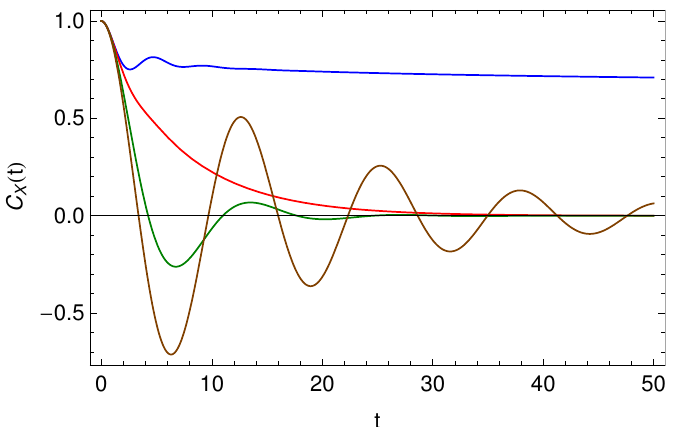
Figure 4. Graphical representation of the normalized displacement correlation function, Equation (45), for γ µ , ρ , δ = 1, τ = 1, ρ = 1/2 µ = 1/2, δ = 3/4, ω = 0.5 and b = 0 (blue line), b = 1 (red line), b = 10 (green line), b = 100 (brown